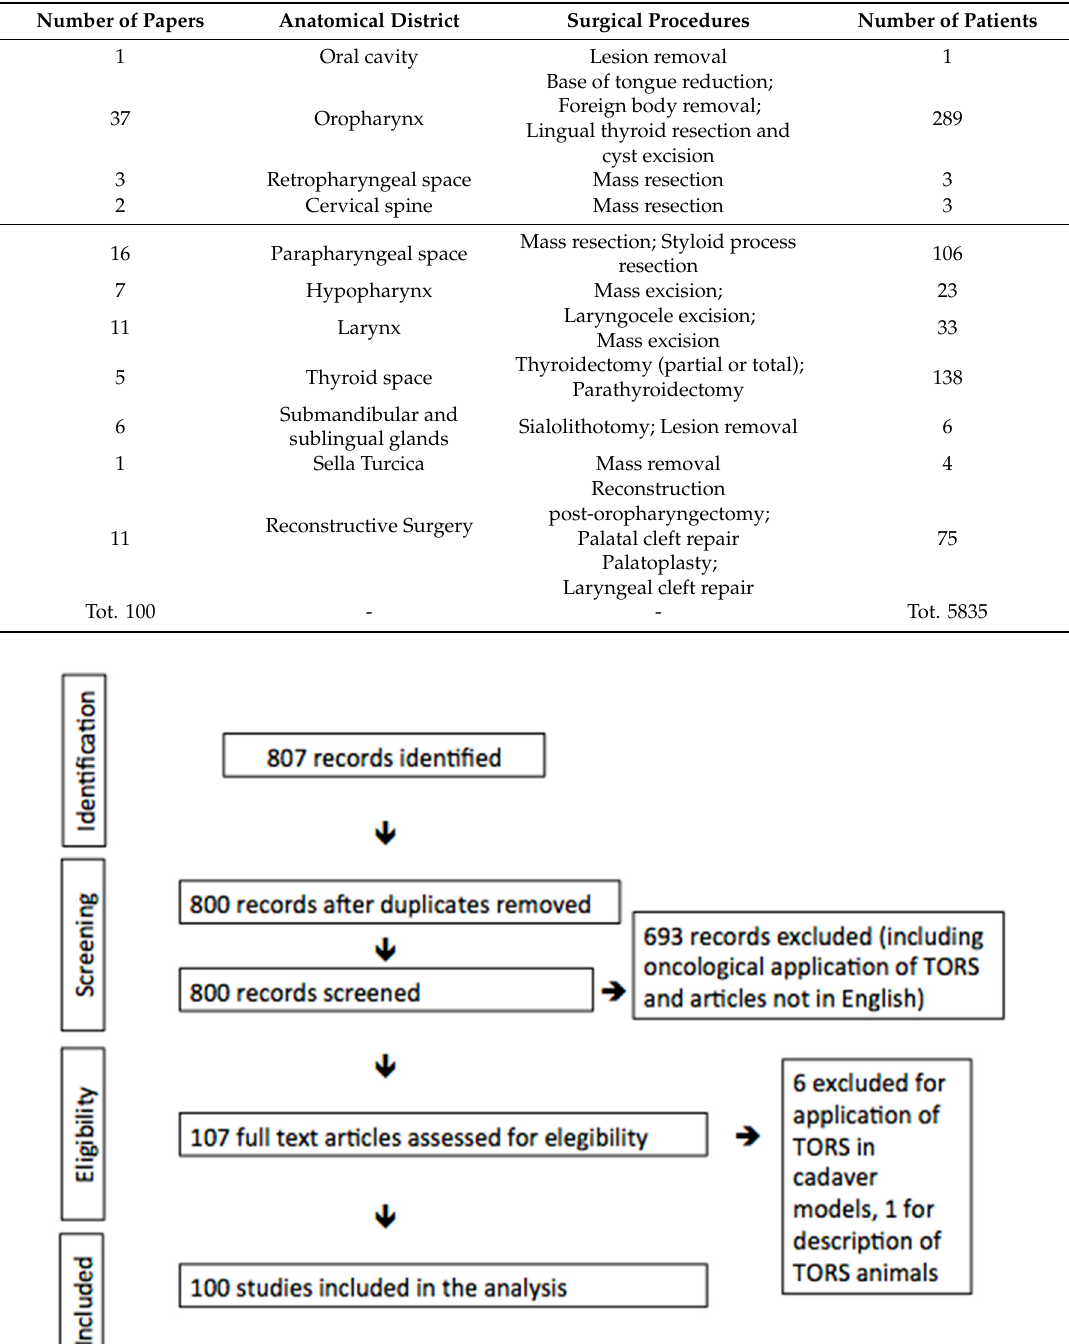
Table 1. Clinical data of papers included in the review.